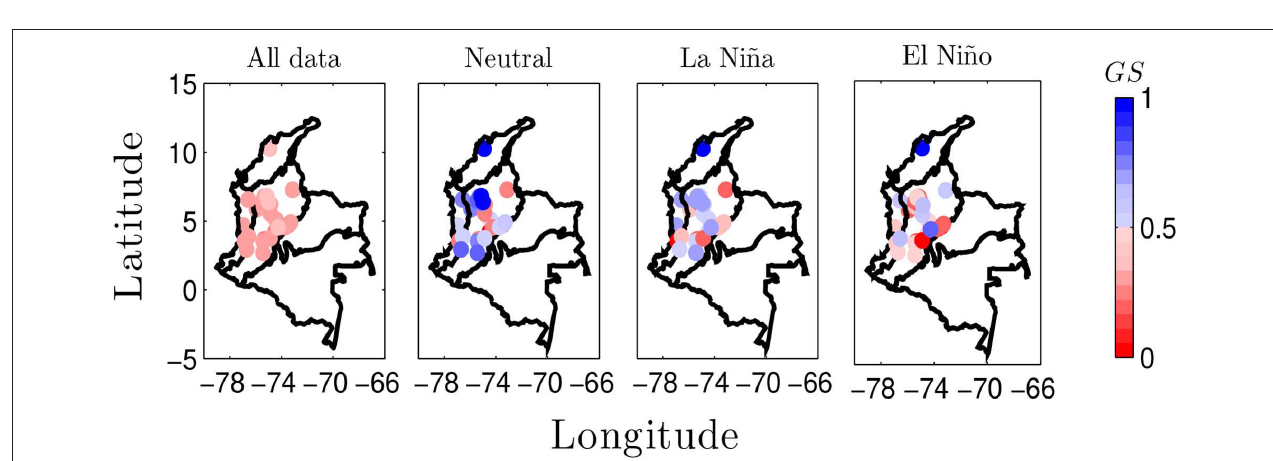
FIGURE 9 | Generalized synchronization index between SST3.4 anomalies and rainfall anomalies in Colombia, Data set No. 1, period 1975–2006. The hatched contours indicates zones where the GS is significant at 5%.